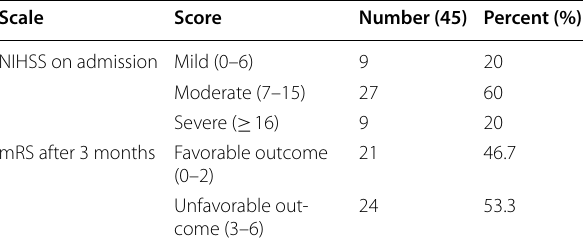
Table 2 Results of NIHSS and mRS in 45 acute ischemic stroke patients